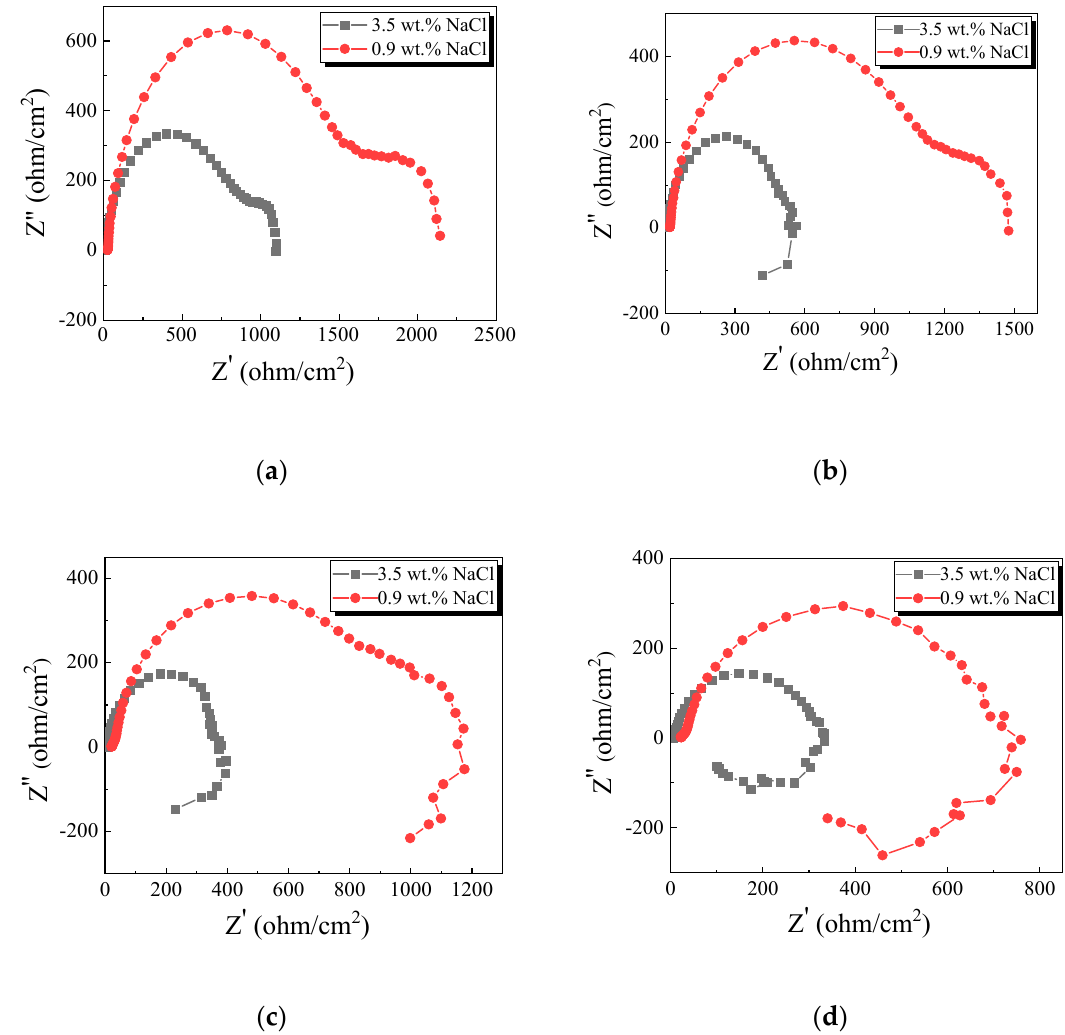
Figure 4. AC impedance spectrum of the Mg-8%Li alloy pre-immersed in 0.9 wt.% NaCl and 3.5 wt.% NaCl solution for different time: ( a ) 0 h, ( b ) 4 h, ( c ) 8 h and ( d ) 24 h. To reflect the corrosion characteristics of the alloy being pre-immersed in two NaCl solutions for different times, electrochemical equivalent circuits were proposed to fit the EIS data, as shown in Figure 5. In the equivalent circuits, R s is the solution resistance. R ct and Q dl represent charge transfer resistance and electric double layer, respectively, at the interface between substrate and electrolyte, which are used to describe the capacitance loop at high frequency. Q dl is a constant phase element that replaces an ideal capacitor to account for the non-homogeneity in the system, which is defined by the two values of Y dl and n dl . Among them, n dl is the dispersion coefficient of Q dl . If n dl = 1, Q dl is identical to a capacitor; if n dl = 0, Q dl represents a resistance. R f and Q f (defined by Y f and n f ) represent film resistance and capacity in the medium frequency capacitance loop, respectively. R L and L stand for resistance and inductance, respectively, which are used to describe the low frequency inductance loop and related to the localized corrosion [36].